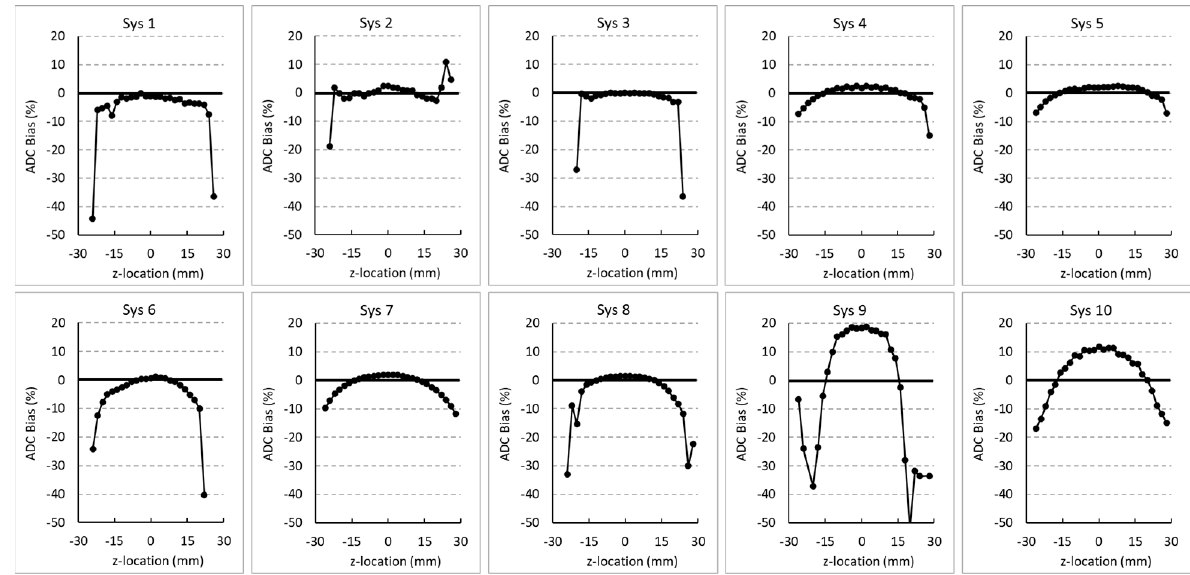
Figure 3. Percent bias of each MRI system relative to Dtrue as a function of z -axis location. Plots of the relative bias (with respect to Dtrue), repeatability, and reproducibility of all 10 systems combined are illustrated in Figure 4. Note, relative bias (solid blue line) was unchanged in Figure 4a–c to display the degree of variability (width of shaded region denotes ± 100 · wSD/Dtrue) relative to bias for short-term (Figure 4a) and